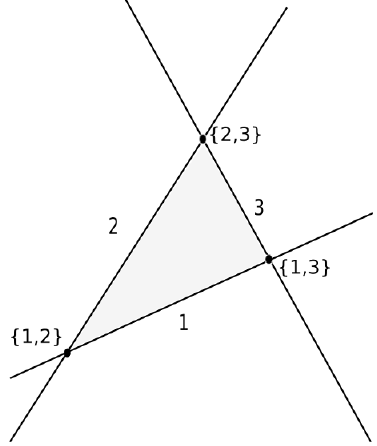
Figure 1 . The depiction of a triangle whose edges are linearly embedded CP 1 ’s in a CP 2